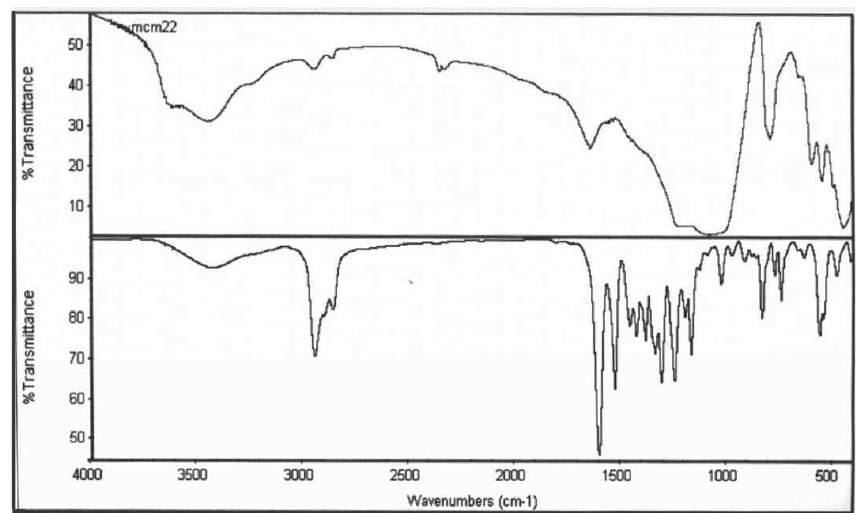
Fig. 3 The FT-IR spectra of the heterogenized sample after excessive washing with ethanol (upper spectrum) and the complex I (lower